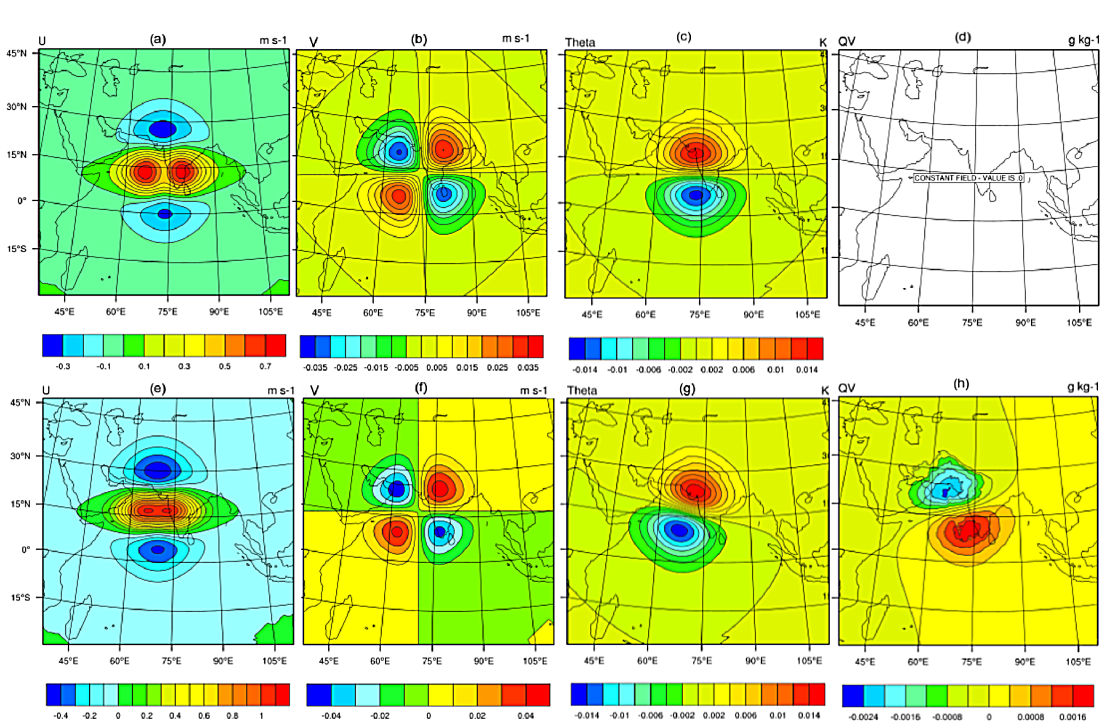
Figure 3. Analysis increment for zonal wind (a, e) , meridional wind (b, f) , potential temperature (c, g) and water vapour mixing ratio (d, h) when a single u -wind observation is assimilated at the middle of the domain at model level 19. Panels (a–d) are for the cv5 run and (e–h) for the cv6